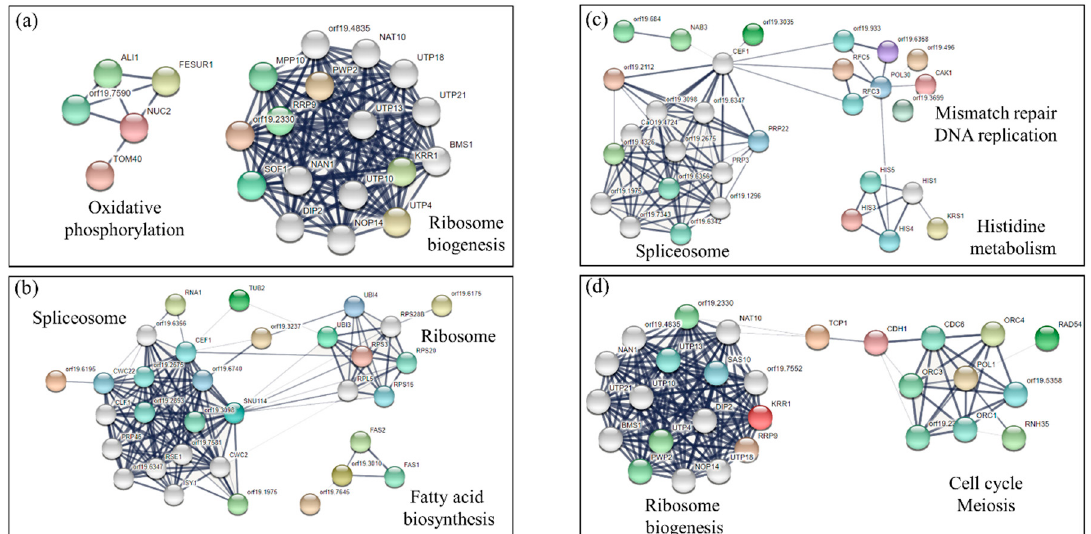
Figure 2. Network obtained with STRING of the enriched functional categories that, when modified in Candida albicans , gave a sensitive GP upon treatment with NOR during biofilm formation ( a ) or when grown in a mature biofilm ( b ), or a tolerant GP upon treatment with NOR during biofilm formation ( c ) or even when grown in a mature biofilm ( d ).